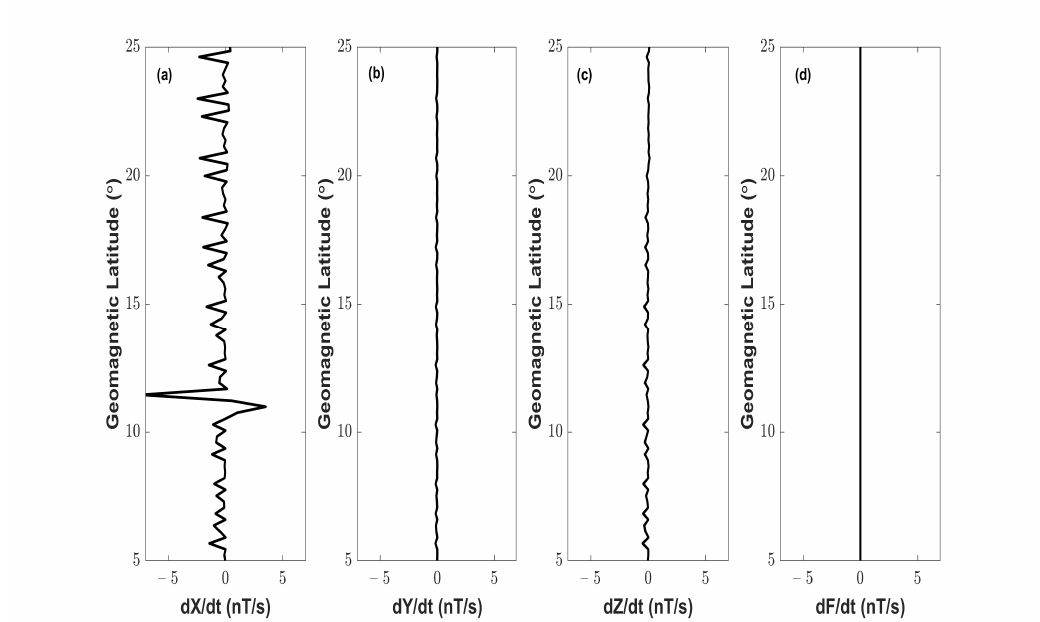
Figure 16. Detection of the anomalous track (track number 15) the magnetic field of the Swarm Satellite C by MASS algorithm on 29 October 2020. From ( a – d ) the first panel to the fourth panel, the x -axis indicates the time derivative of X, Y, Z, and scalar components of the magnetic field, respectively. The y -axis indicates the geomagnetic